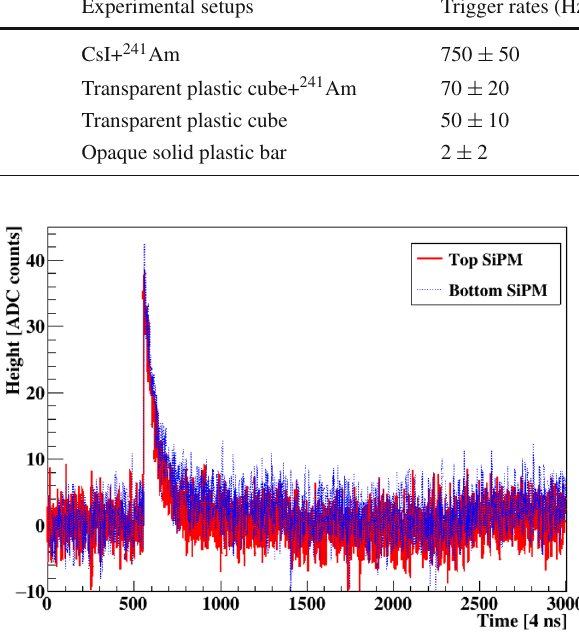
Fig. 14 Waveforms from a common event taken with the transparent cube